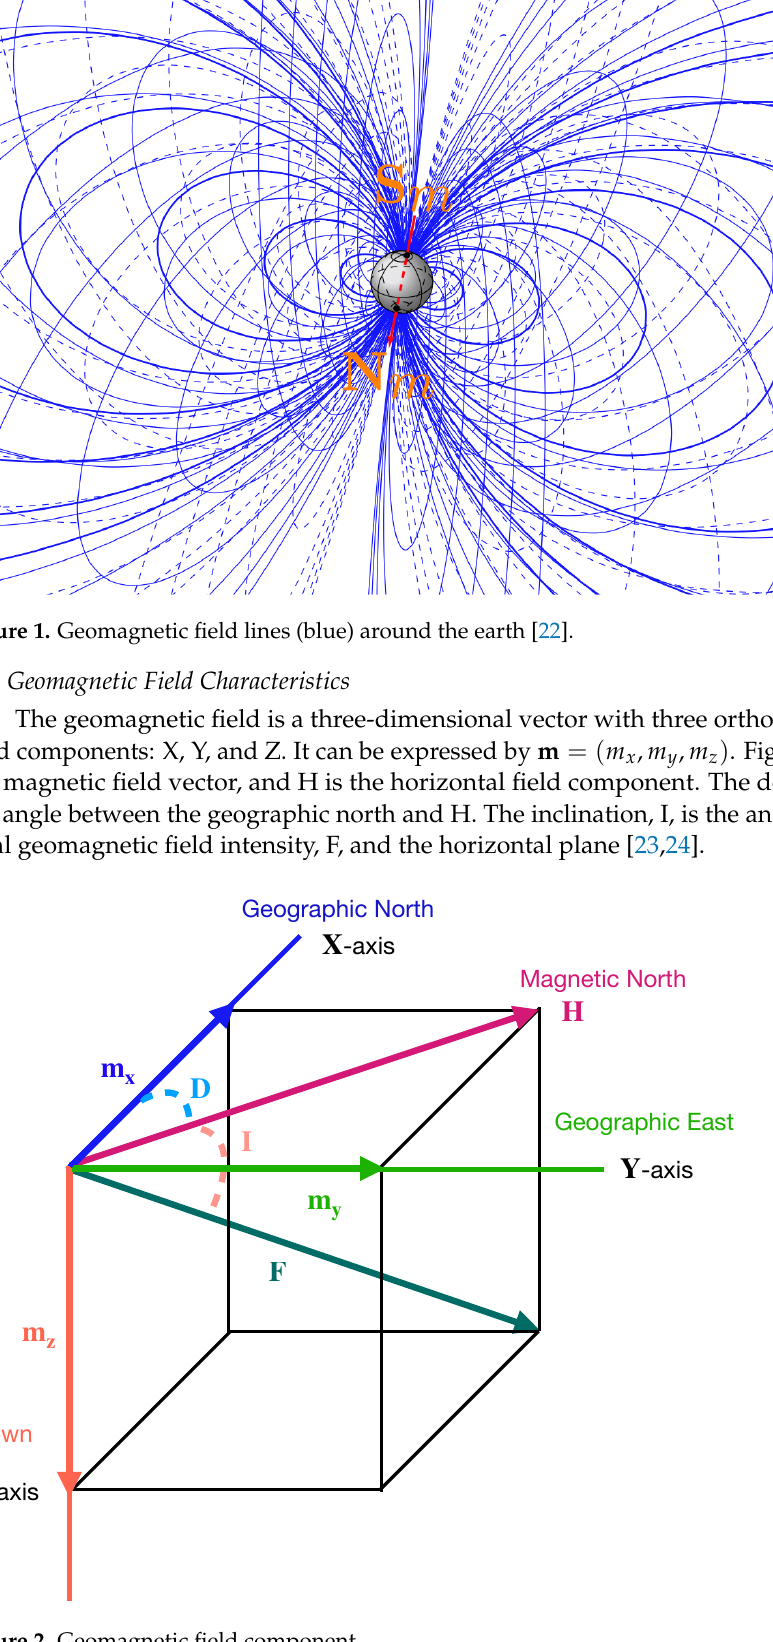
Figure 2. Geomagnetic field